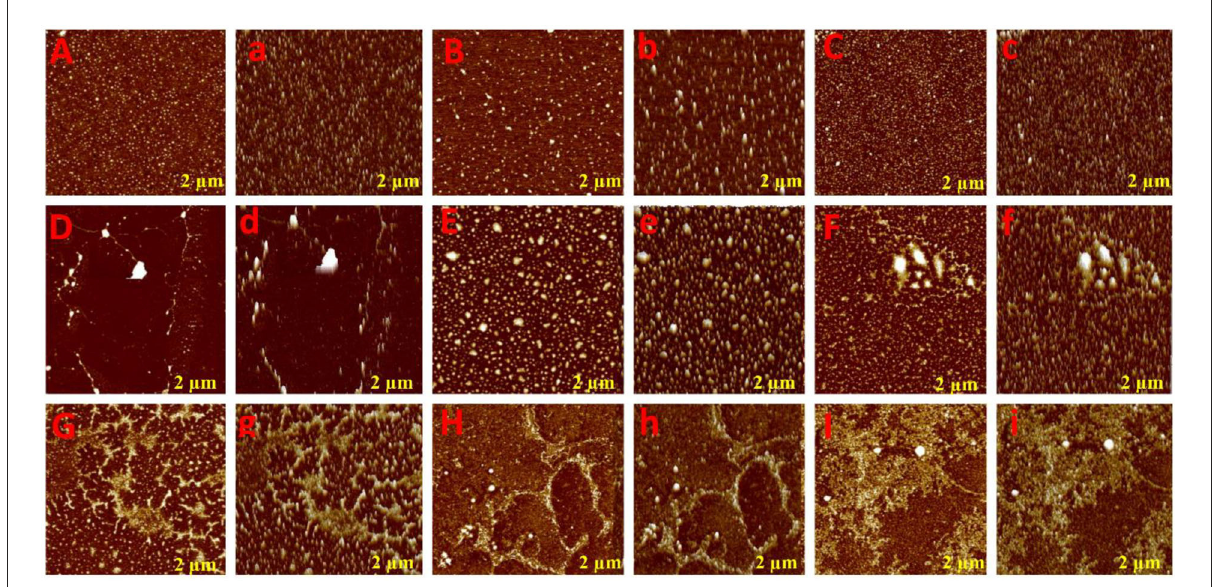
FIGURE2 Atomic force microscopic analysis of phenolic compounds with XOD. Aa (XOD only), Bb (C8: 3-O-caffeoylquinic acid), Cc (C7: 4-O-caffeoylquinic acid), Dd (C6: caffeic acid), Ee (C5: 3,4-O-dicaffeoylquinic acid), Ff (C4: 3,5-O-dicaffeoylquinic acid), Gg (C3: 4,5-O-dicaffeoylquinic acid), Hh (C2: quercetin-3-O-rhamnoside), and Ii (C1: